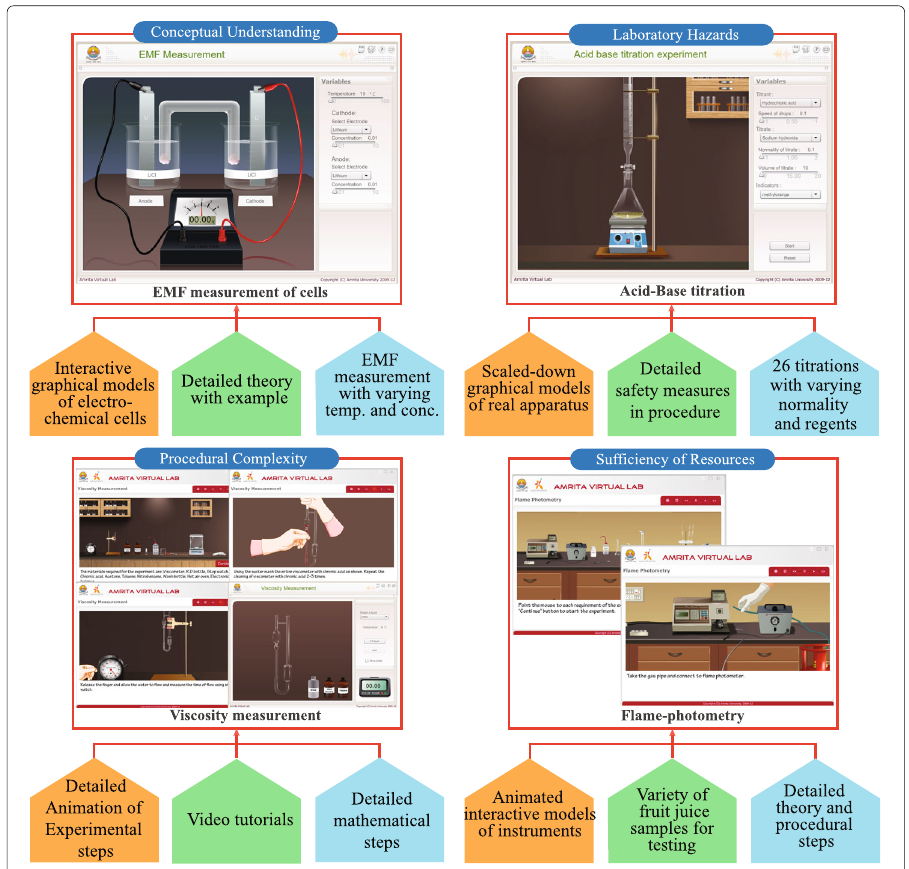
Fig. 3 Features of virtual laboratory experiments to address four factors (conceptual understanding, laboratory hazards, procedural complexity and lack of sufficient